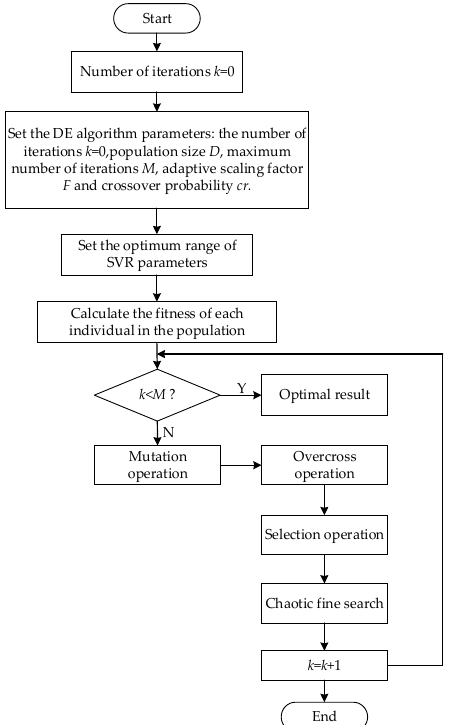
Figure 2. Flow diagram of adaptive chaos differential evolution-support vector regression (ACDE- SVR)